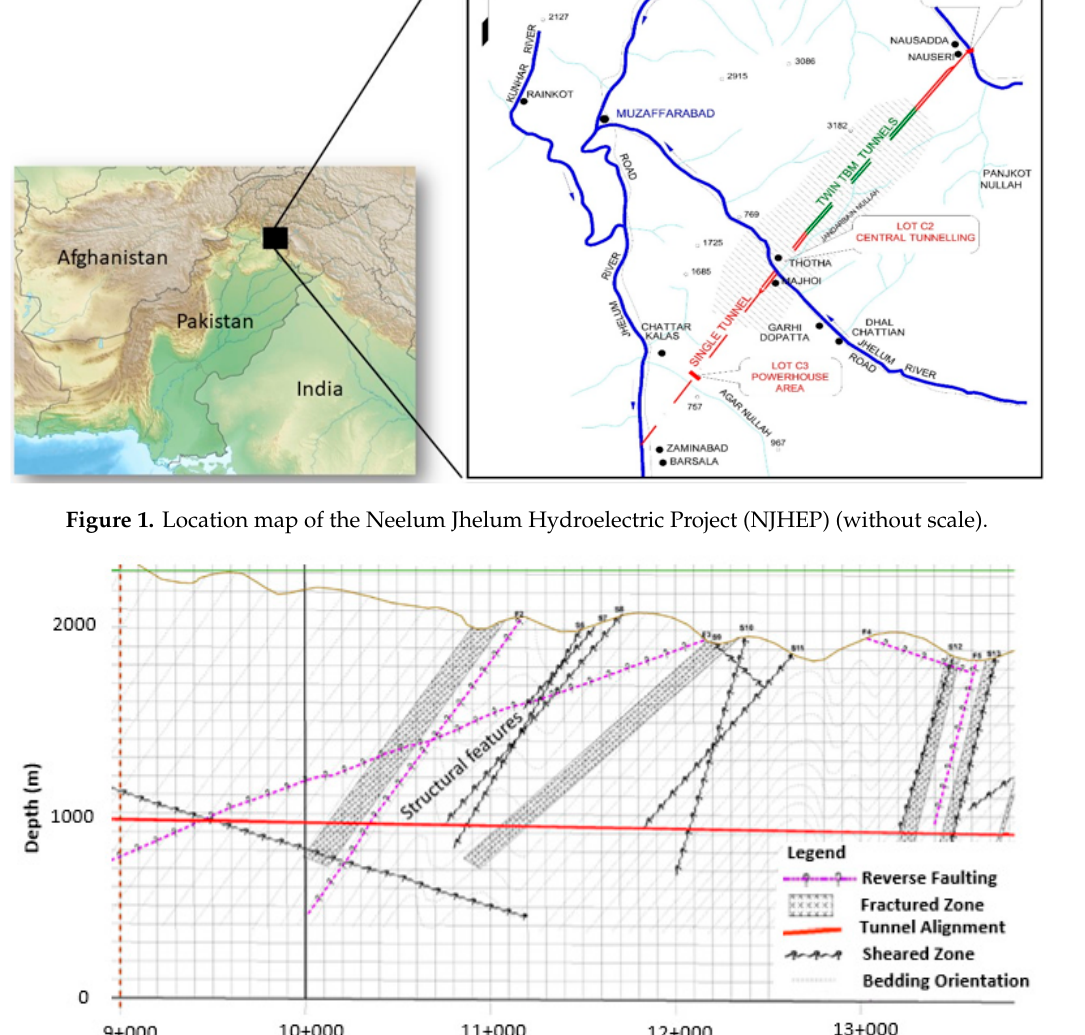
Figure 3. The ratio (K 0 ) between horizontal to vertical stress at various depths, z (m) of the NJHEP project area. 1.2. The Presence of Shear Zones in the Project Area The NJHEP is located in a tectonically active range of the Himalayas, which is pierced by a series of regional thrust faults: the main front thrust, the main boundary thrust, the main central thrust, and the main mantle thrust [24–26]. These structures have been originated by the collision between two plate boundaries from the Mesozoic to late Cenozoic period. The headrace tunnels pass through the Murree Formation, which has a highly deformed geology due to tectonic stresses. As a consequence, different types of geological structures such as folds, faults, and shear zones are present in the area [27,28]. There are three local faults in the area: the Tanda fault, the Murree fault, and the Muzaffarabad fault. Details about these local faults are beyond the scope of this study, but the initial geological mapping program [29] of the NJHEP project reported 15 local, small-scale, sharp fault planes (denoted with “F” in series) and 26 shear zones present along the headrace tunnels. Among these faults and shear zones, few structures are expected to pass near a rockburst-susceptible environment, such as F2 and F3 as shown in Figure 2. F2 has an expected invert level chainage of 10 + 360 (m) with an orientation of 62/058 (dip/dip direction), while F3 has an expected invert level chainage of 9 + 350 (m) with an orientation of 25/080. The NJHEP headrace tunnels also pass near many shear zones due to these complex geological conditions. Some of these are present at the contact